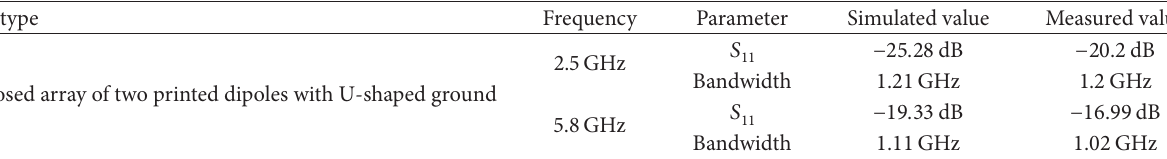
Table 2: Results of proposed prototype antenna array.